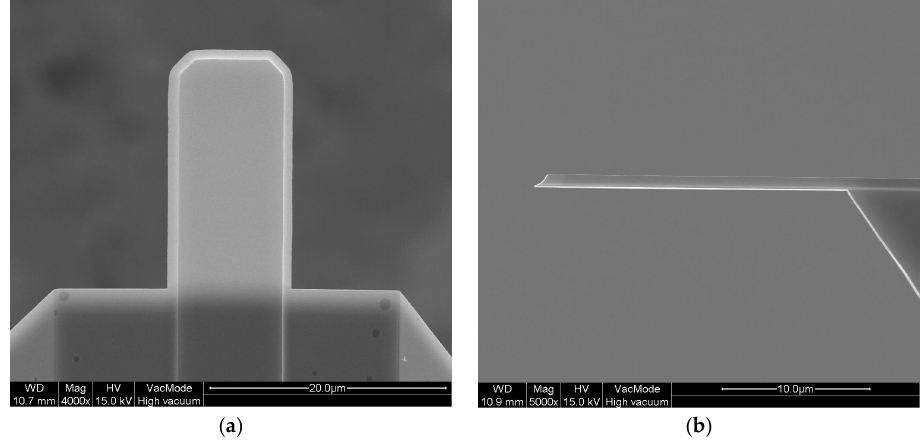
Figure 1. Field emission scanning electron microscopy pictures of the micromechanical resonator: ( a ) top-view; ( b ) side-view.